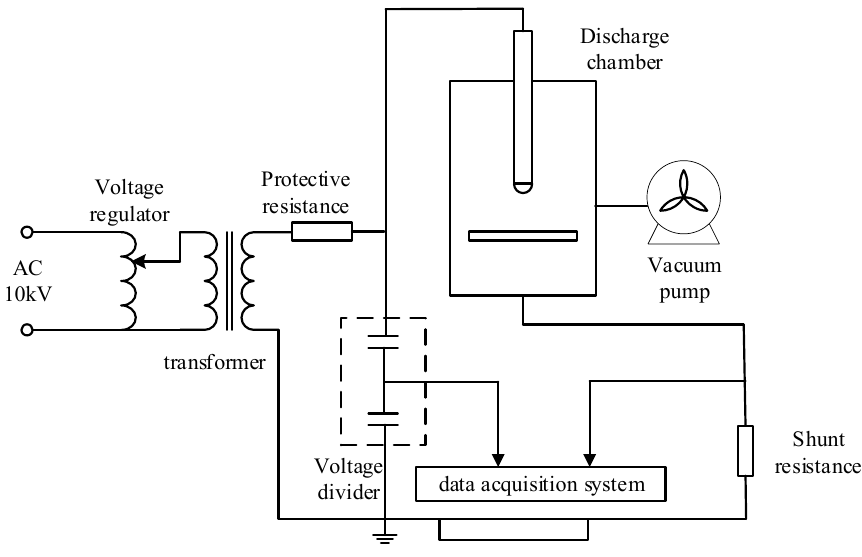
Figure 8. Schematic diagram of test wiring.